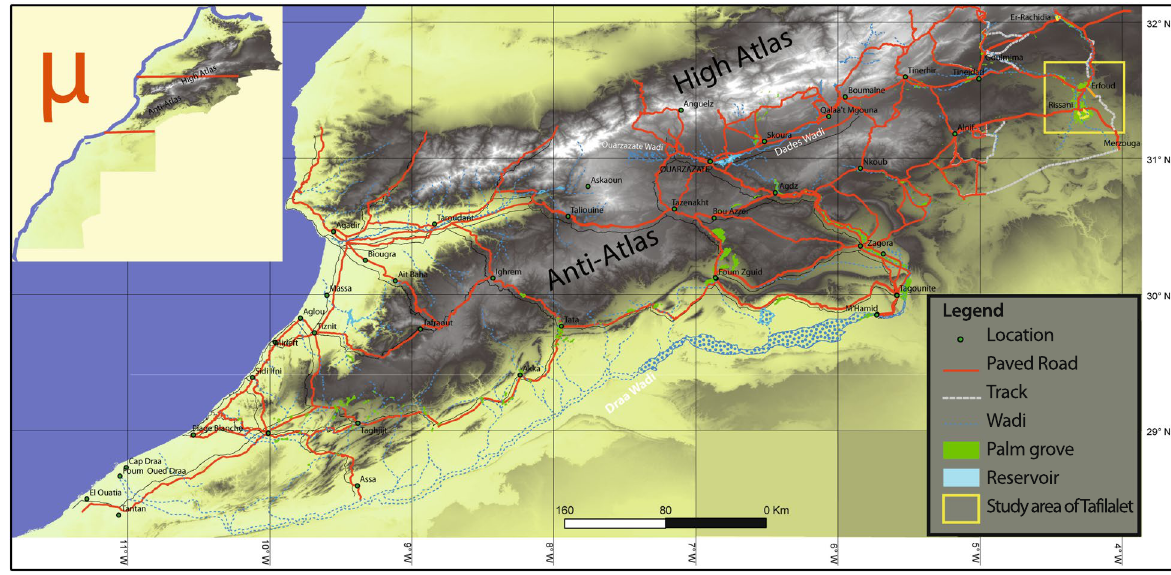
Fig. 1 The study area location map (Source: the